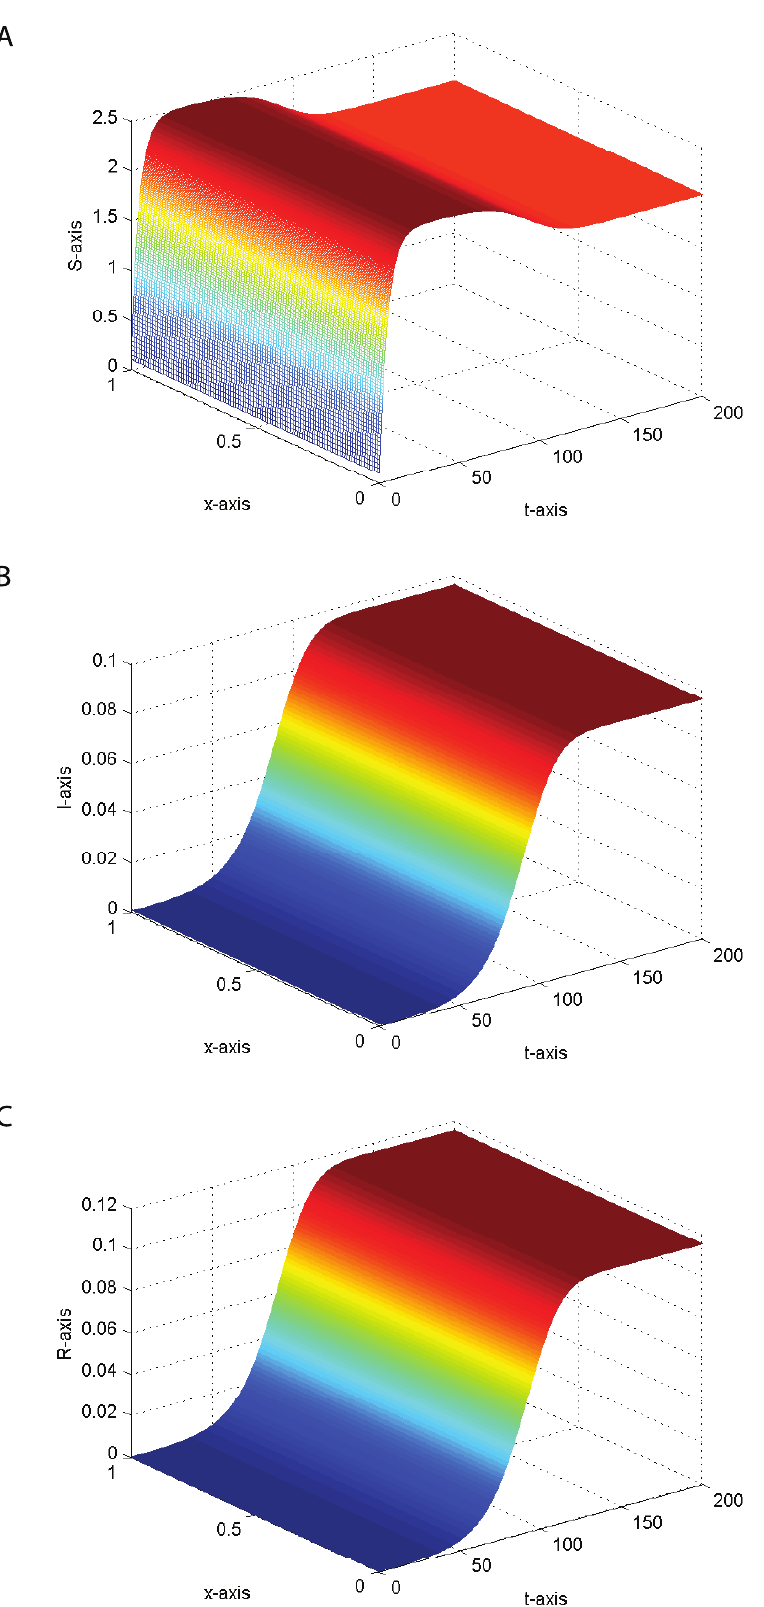
Figure 3. The temporal solution found by numerical integration of problem (0.3) under conditions (0.4) and (0.15) with B ~ 0 : 5 , b ~ 0 : 5 , ª ~ 0 : 6 , a ~ 0 : 1 , m 1 ~ 0 : 2 , m 2 ~ 0 : 4 , m 3 ~ 0 : 5 , D ~ 10 , t ~ 2 and d 1 ( x , t ) ~ 0 : 1 , d 2 ( x , t ) ~ 0 : 001 , d 3 ( x , t ) ~ 0 : 0001 , t [ ½ { 2 , 0 (cid:2) .